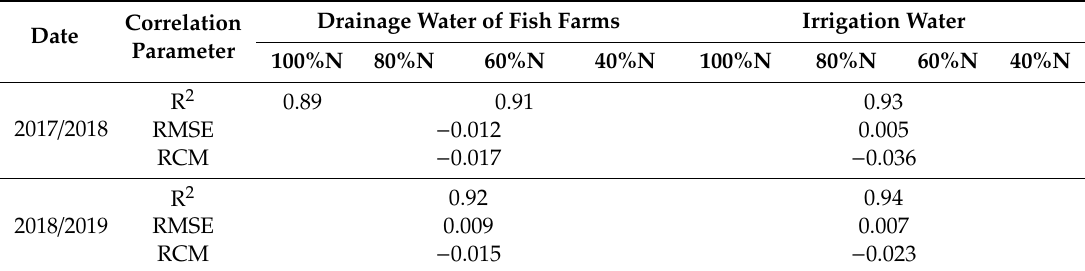
Table 7. Coe ffi cient of determination (R 2 ), root mean square error (RMSE), and residual mass factor (CRM) coe ffi cients for soil moisture in one layer depth (0–30 cm) for all irrigation